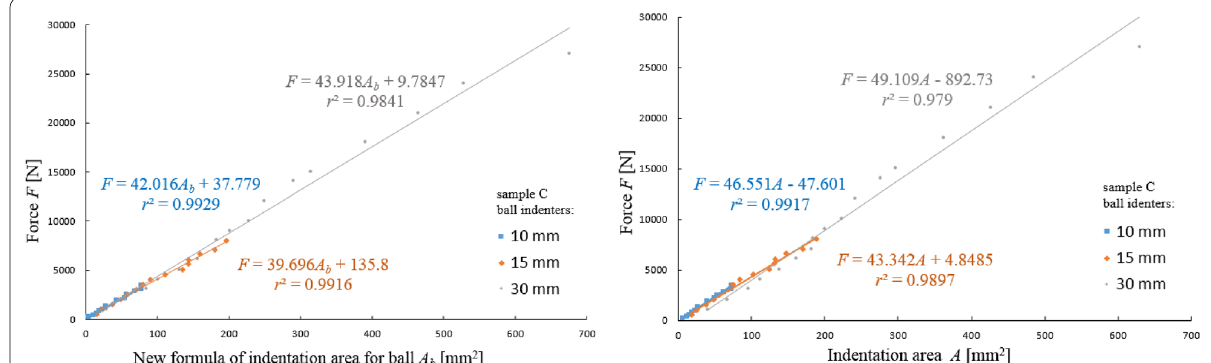
Fig. 9 Charts of the dependency of force F of indenter on the measure of the indentation area for three ball indenters for sample C. On the left, the chart for the new measure of the area A b , and on the right for the total area of indentation A